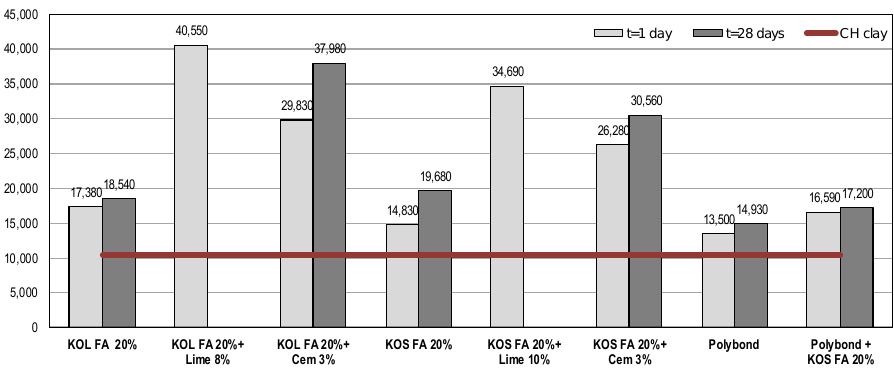
ff erent mixtures with CH clay. Figure 5. Compressibility parameters of different mixtures with CH clay.